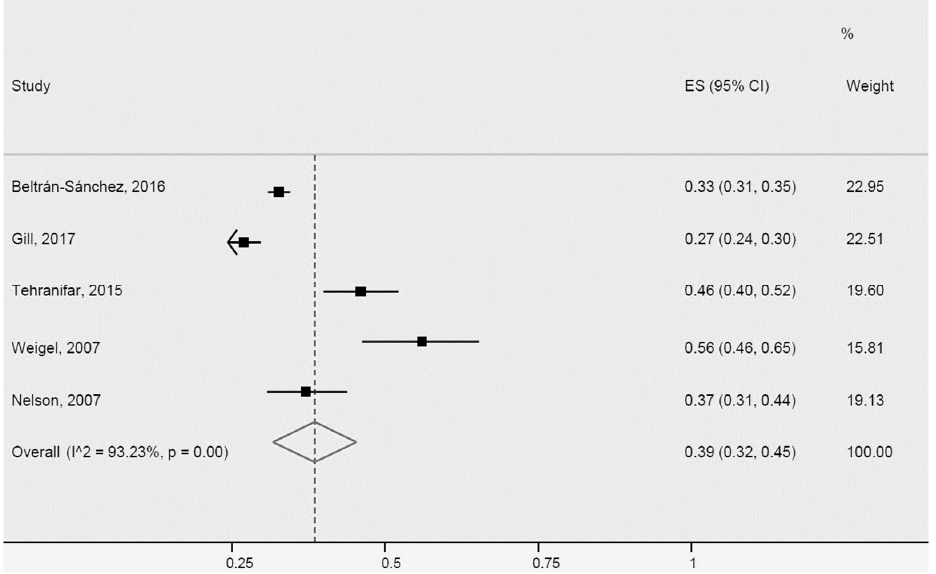
Figure 11. Metabolic Syndrome for Latinos in the US. ES = Estimated proportion/prevalence; CI = Confidence interval; I^2 = I 2 index.